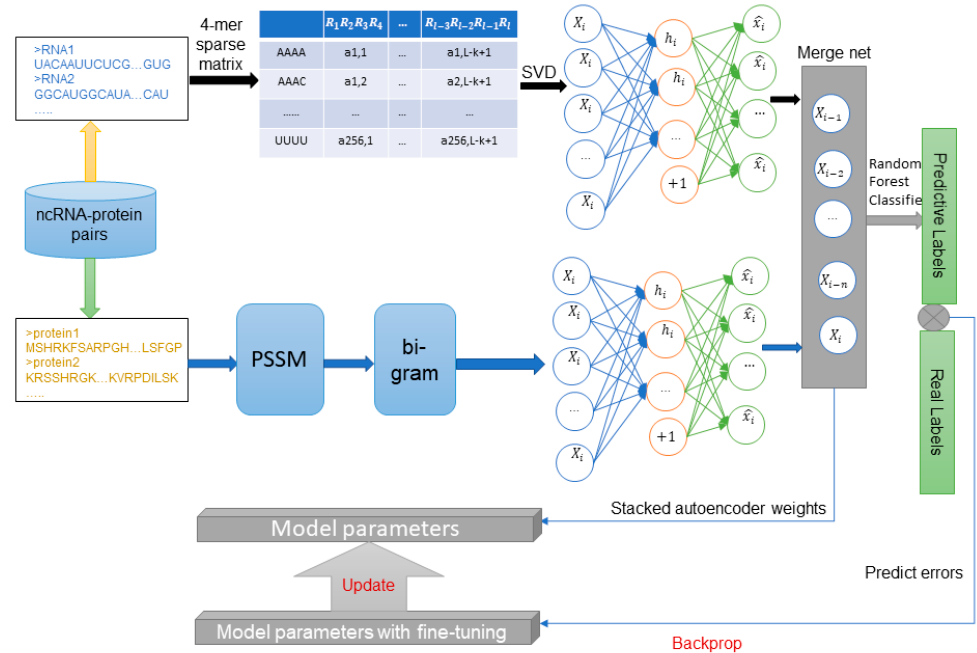
Figure 1. Step-wise work flow for the proposed BGFE method. In the non-coding RNA (ncRNA) and protein sequences used for training and prediction, Singular Value Decomposition (SVD) converts ncRNA sequences into feature vectors from 4-mer sparse matrices, while protein sequences are represented by bi-gram algorithm form Position Specific Scoring Matrix (PSSM). These feature vectors are processed by multi-layer stack auto-encoder to obtain deeper feature information. Subsequently, training data and labels are fed into a random forest classifier for classification training. In addition, fine-tuning the model parameters after obtaining the machine learning model further contributes the model accuracy.